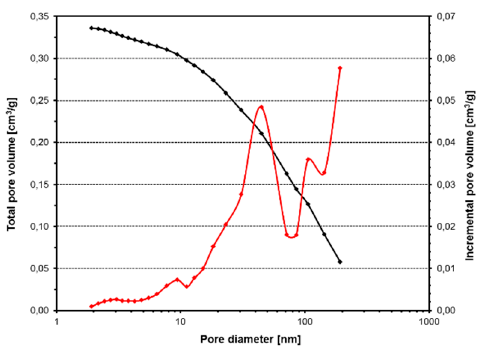
Figure 1. Pore size distribution analysis for the INS Ni precursor.